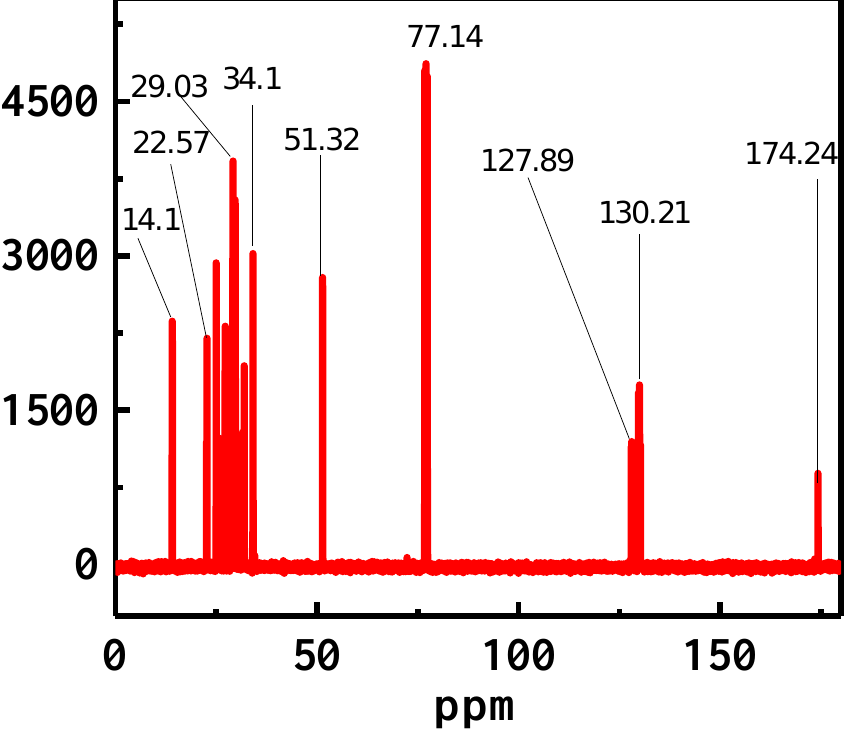
Figure 9. 13 C NMR spectrum of RT FAMEs.